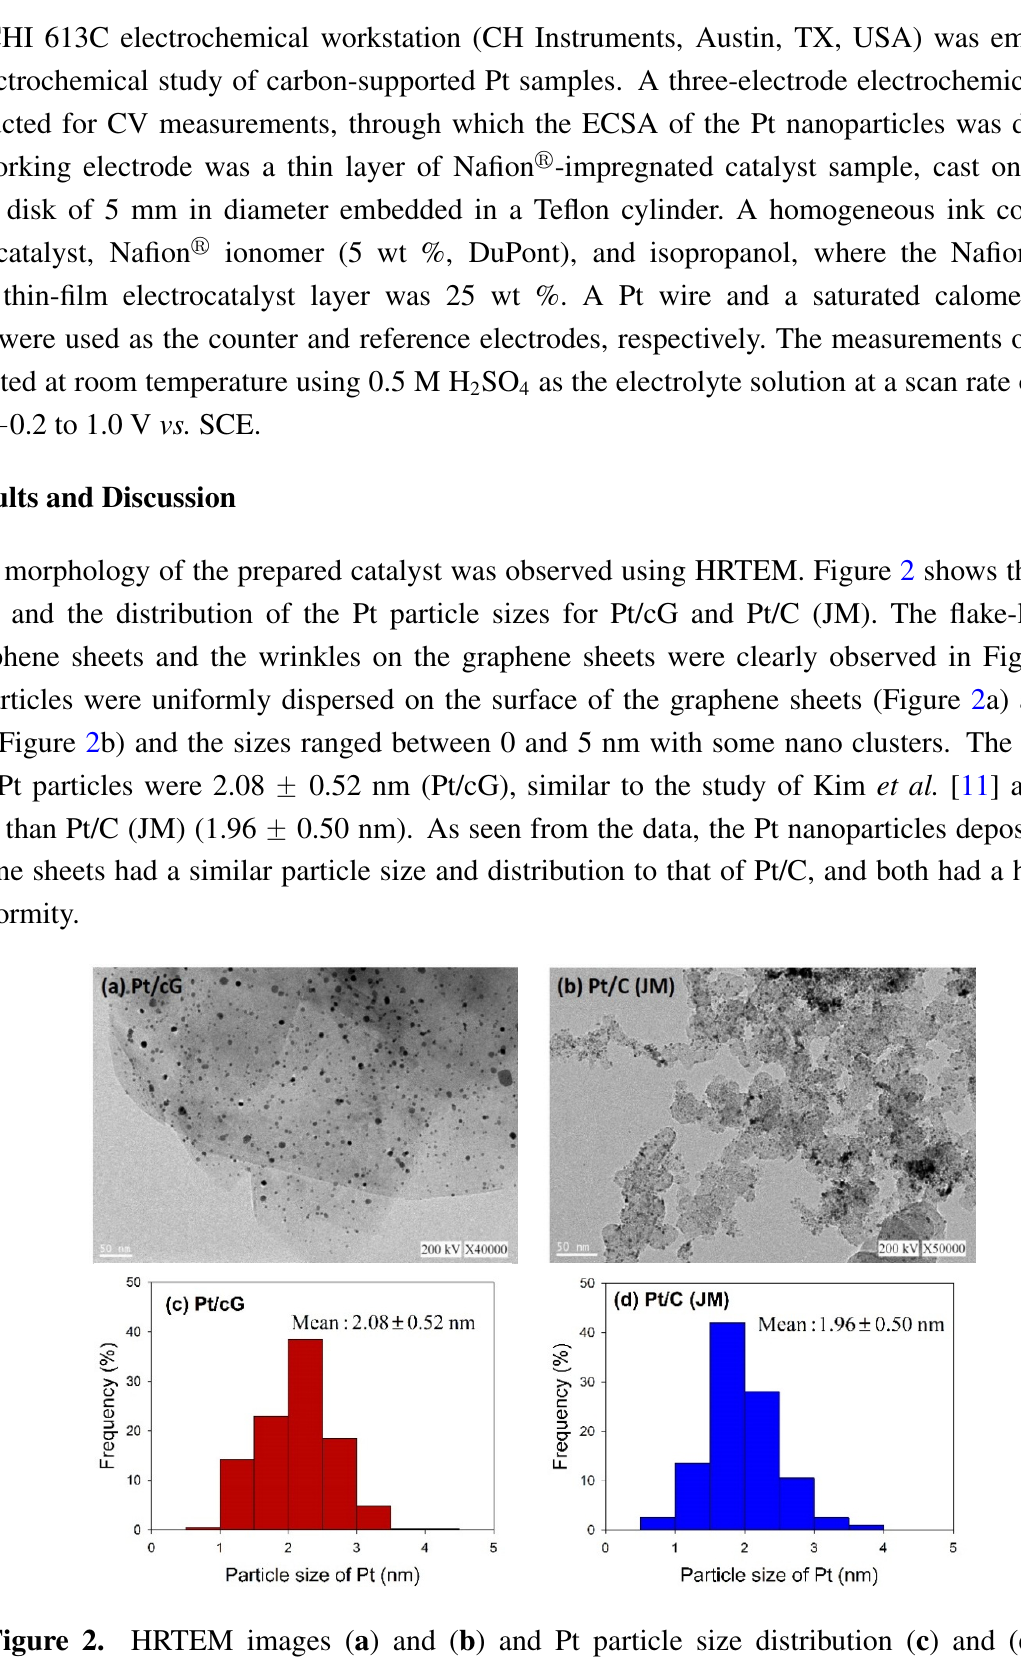
Figure 2. HRTEM images ( a ) and ( b ) and Pt particle size distribution ( c ) and ( d ) of the samples.